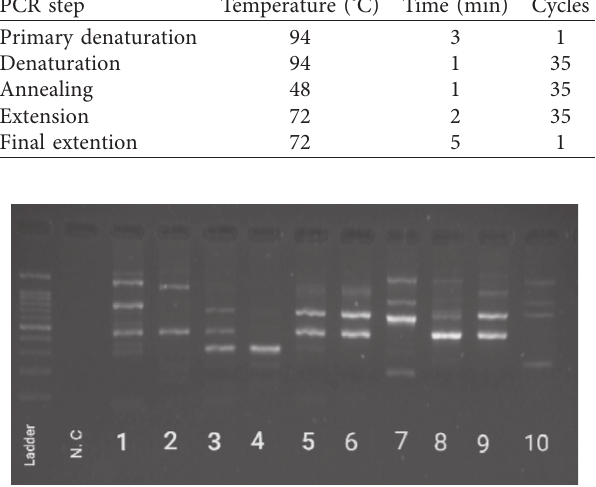
Figure 1: Agarose gel after electrophoresis and ultraviolet illu- mination. N. C: Negative